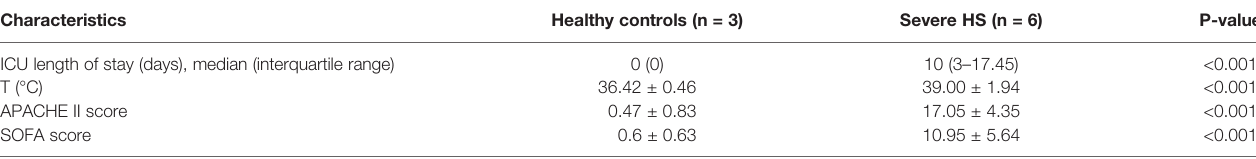
TABLE 1 | Basic clinical characteristics and disease severity scores of the participants. Characteristics